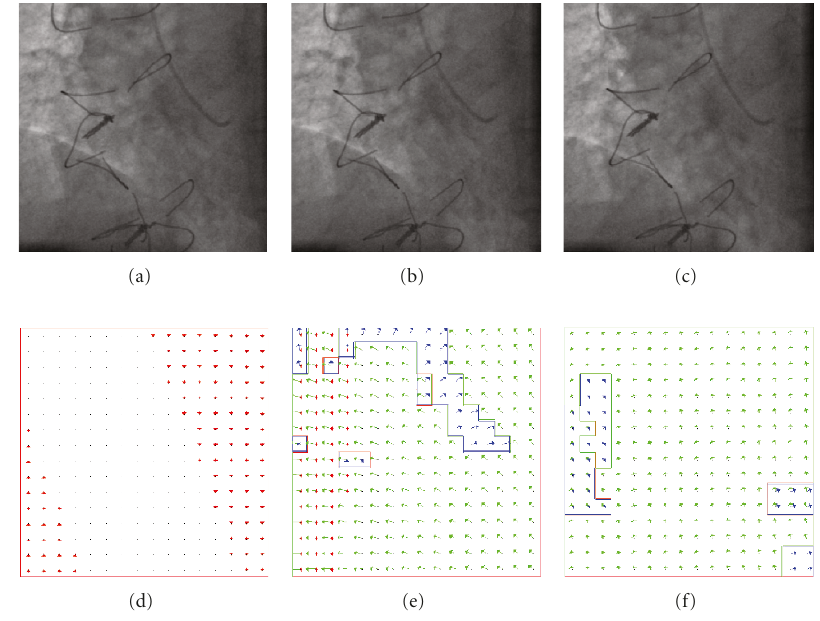
Figure 7: Second example of a X-ray interventional cardiac image sequence, (a)–(c): Images acquired at three di ff erent time instants, (d), (e), (f): the corresponding velocity fields supplied by the estimated a ffi ne motion models, plotted in di ff erent colours according to the transparent layer they are belonging to. (a) Illustration of the method ability to detect single layer situations; (b) correct segmentation and estimation of the motions of small objects, even included in noisy images; (c) handling of a transparency situation with three simultaneous transparent layers in some areas (see main text).